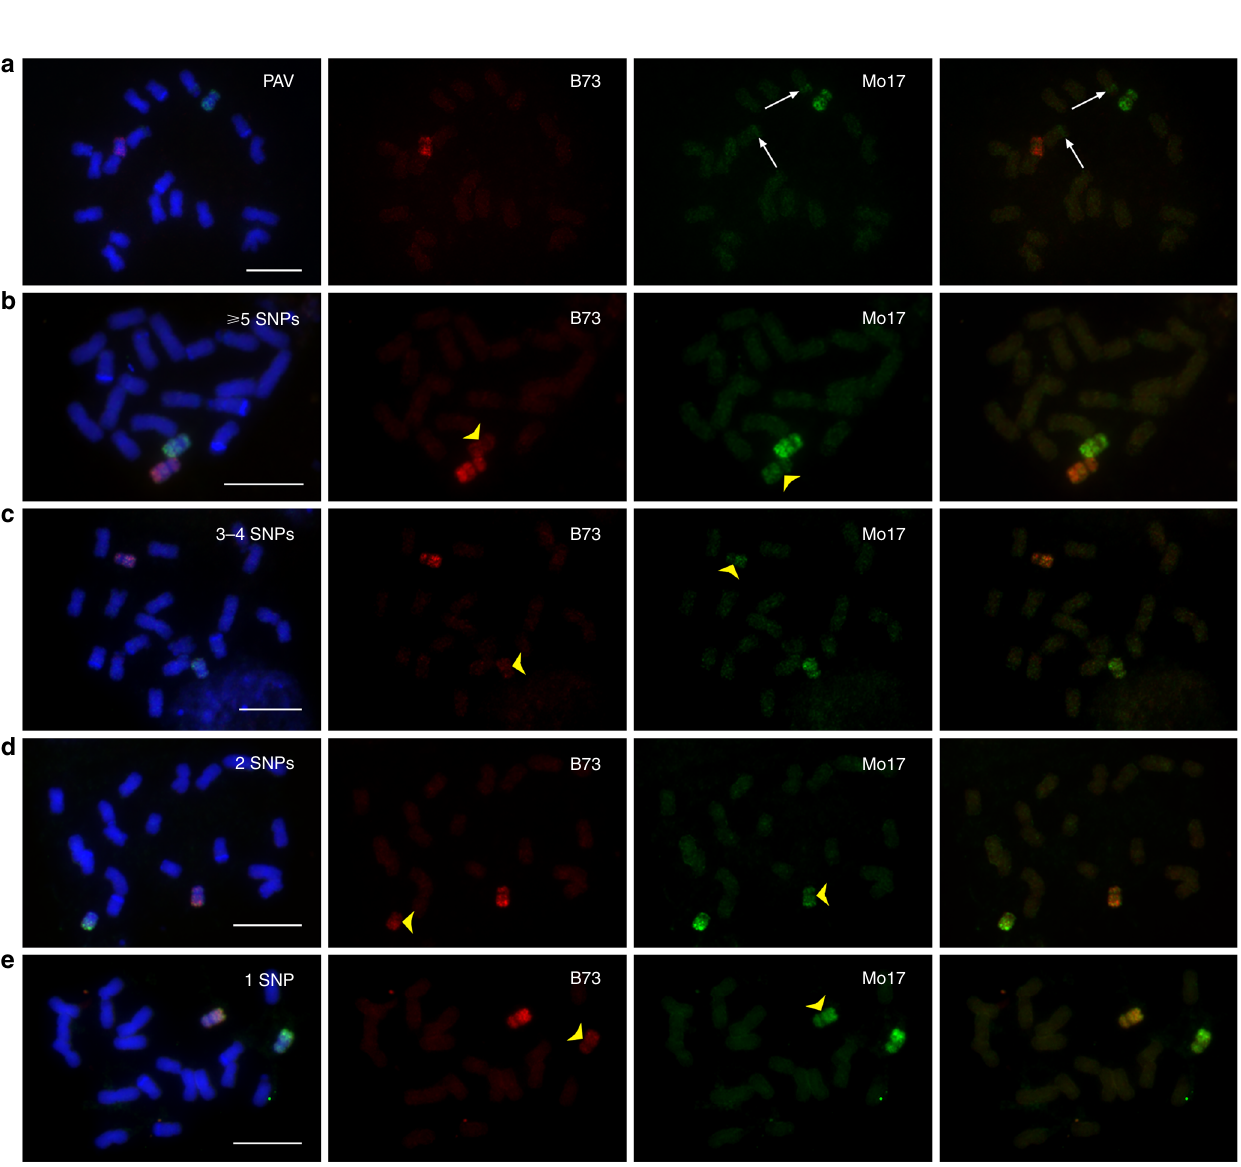
Fig. 1 Development of maize chromosome 10 oligo-FISH probes speci fi c to inbreds B73 or Mo17. a Two oligo-FISH probes based on presence-absence variation. b Two oligo-FISH probes based on 5 or more single nucleotide polymorphisms (SNPs). c Two oligo-FISH probes based on 3 or 4 SNPs. d Two oligo-FISH probes based on 2 SNPs. e Two oligo-FISH probes based on 1 SNP. Oligo-FISH probes speci fi c to the B73 haplotype were detected in red color. Oligo-FISH probes speci fi c to the Mo17 haplotype were detected in green color. Images in fi rst column: Complete metaphase cells hybridized with the two FISH probes; Images in the second column: digitally separated red FISH signals derived from the B73-speci fi c probes; Images in the third column: digitally separated green FISH signals derived from the Mo17-speci fi c probes; Images in the forth column: merged FISH signals derived from both B73 and Mo17. Arrows indicate the cross-hybridization signals at the 45 rDNA region associated with chromosome 6. Yellow arrowheads indicate the cross-hybridization signals from B73-speci fi c probes to Mo17 chromosome 10, and vice versa. Bars = 10 μ m. The original gray-scale images used to generate the fi ve color images in the fi rst column of all panels of Fig. 1 are provided as a Source Data fi